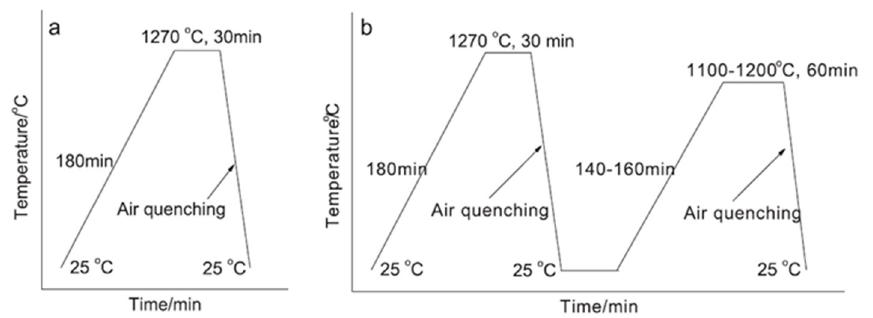
Figure 2. Calcination process of belite–calcium sulfoaluminate-ternesite system. ( a ) one-stage calcination process, and ( b ) secondary heat treatment process [42].